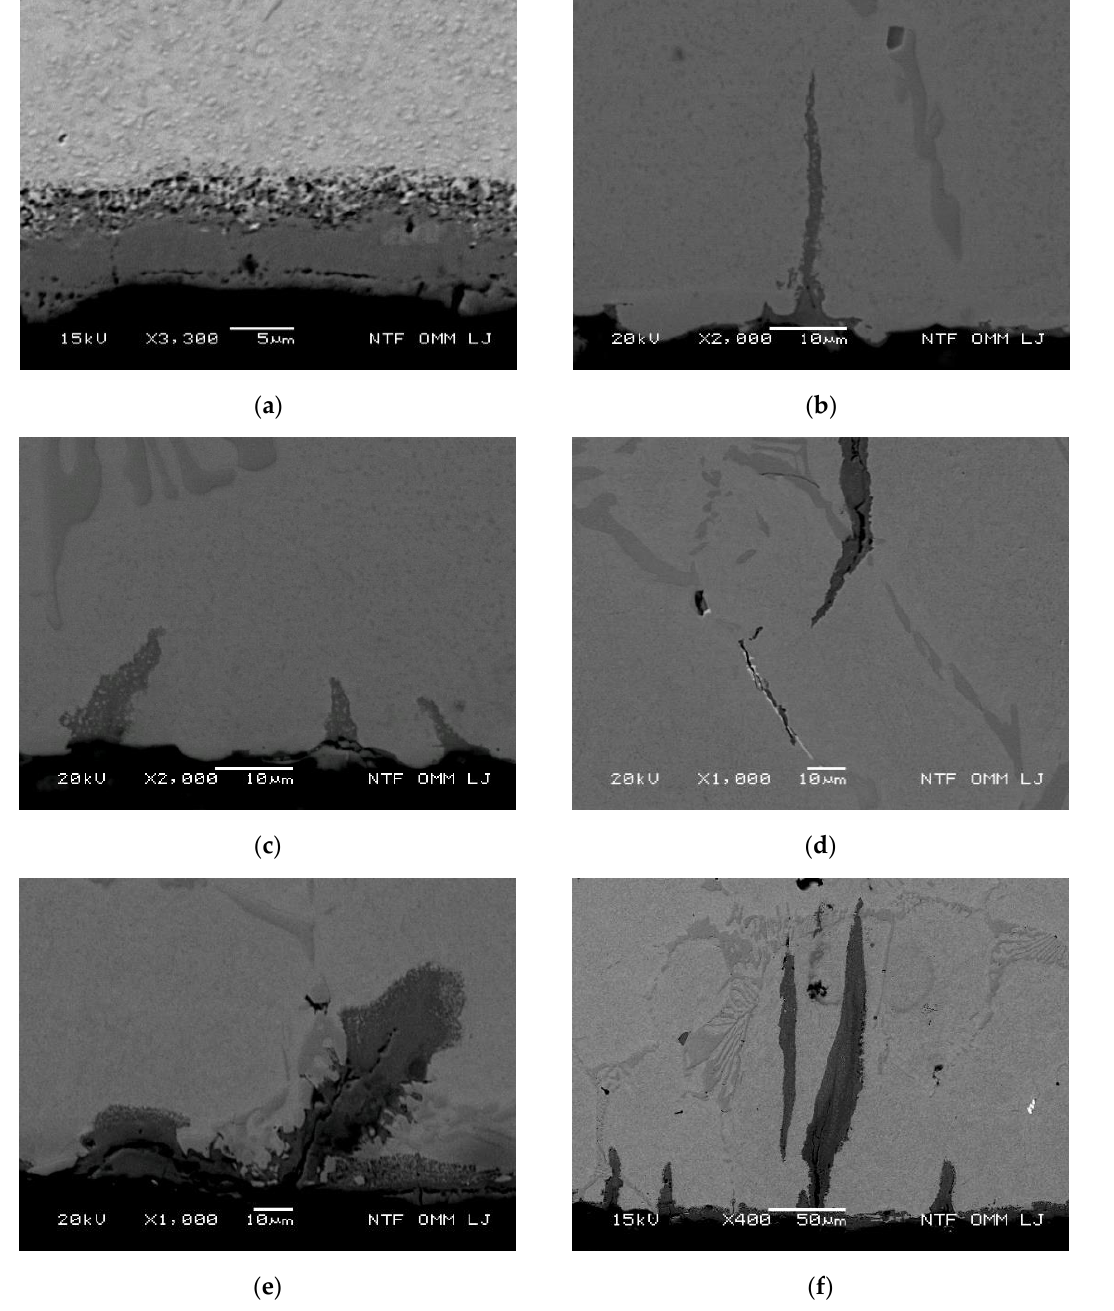
Figure 7. Oxidation in the matrix and cooled surface: ( a ) oxidation of surface after 2500 cycles at 700 °C, ( b , c ) oxidation tongues after 1000 cycles at 600 °C, ( d ) oxidation direction deviation toward internal crack tip, ( e ) increased oxide band originating on the small cracked carbide after 1000 cycles at 700 °C and ( f ) larger oxide tongue in the matrix originating from the surface after 2500 cycled at 700 °C.